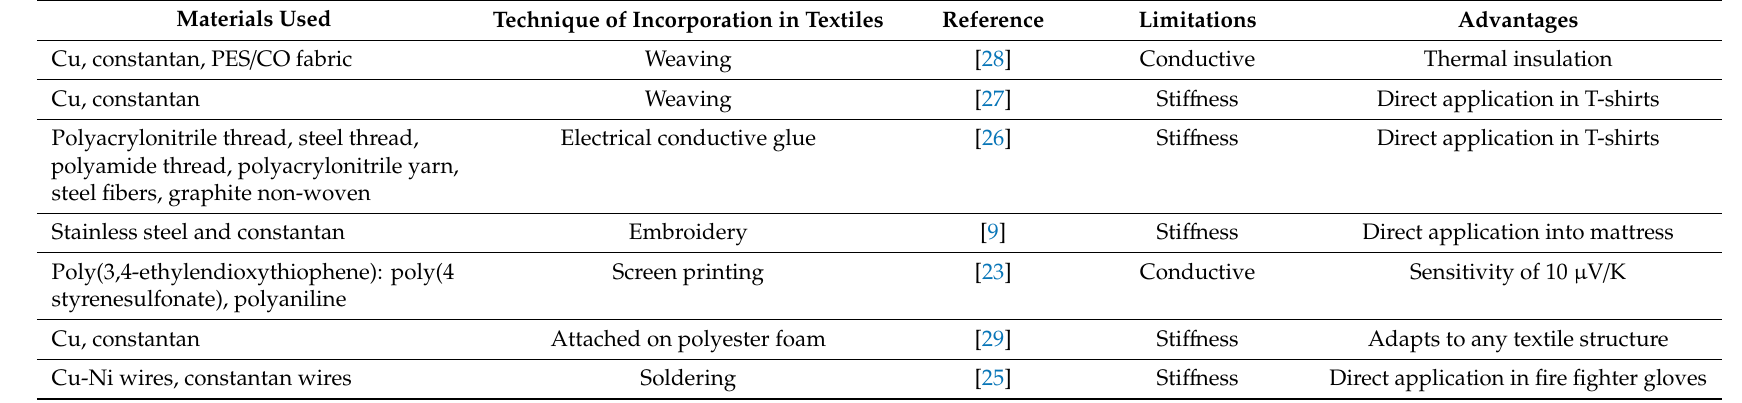
Table 1. Thermocouples used for temperature measurement in